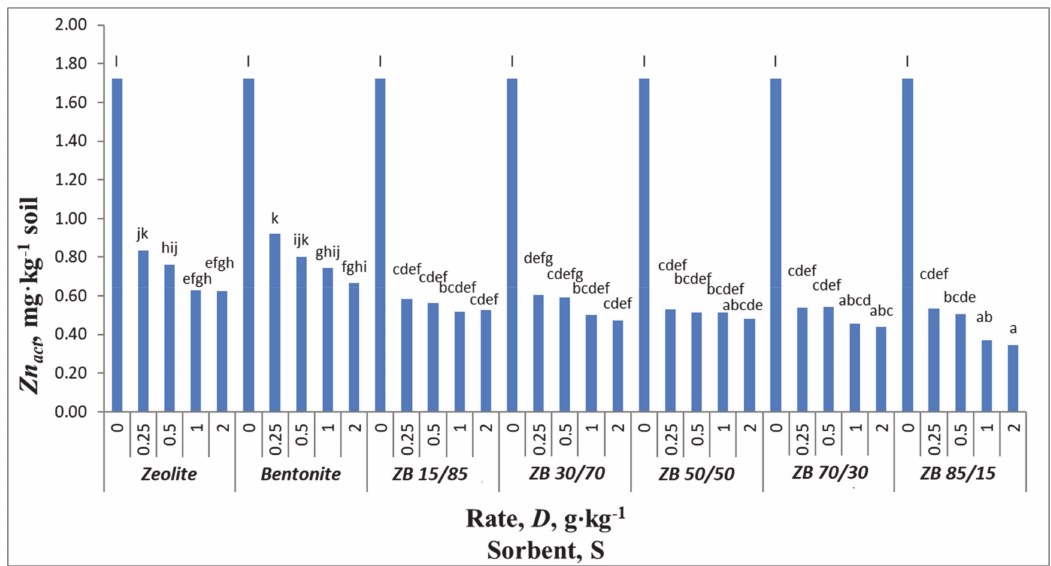
Figure 2. Content of the active zinc fraction ( Zn act ) on the background of interactions sorbent ( S ) and rates ( D ). Small letters a to l refer to statistical differences among the tested treatments, the same letter means no significant